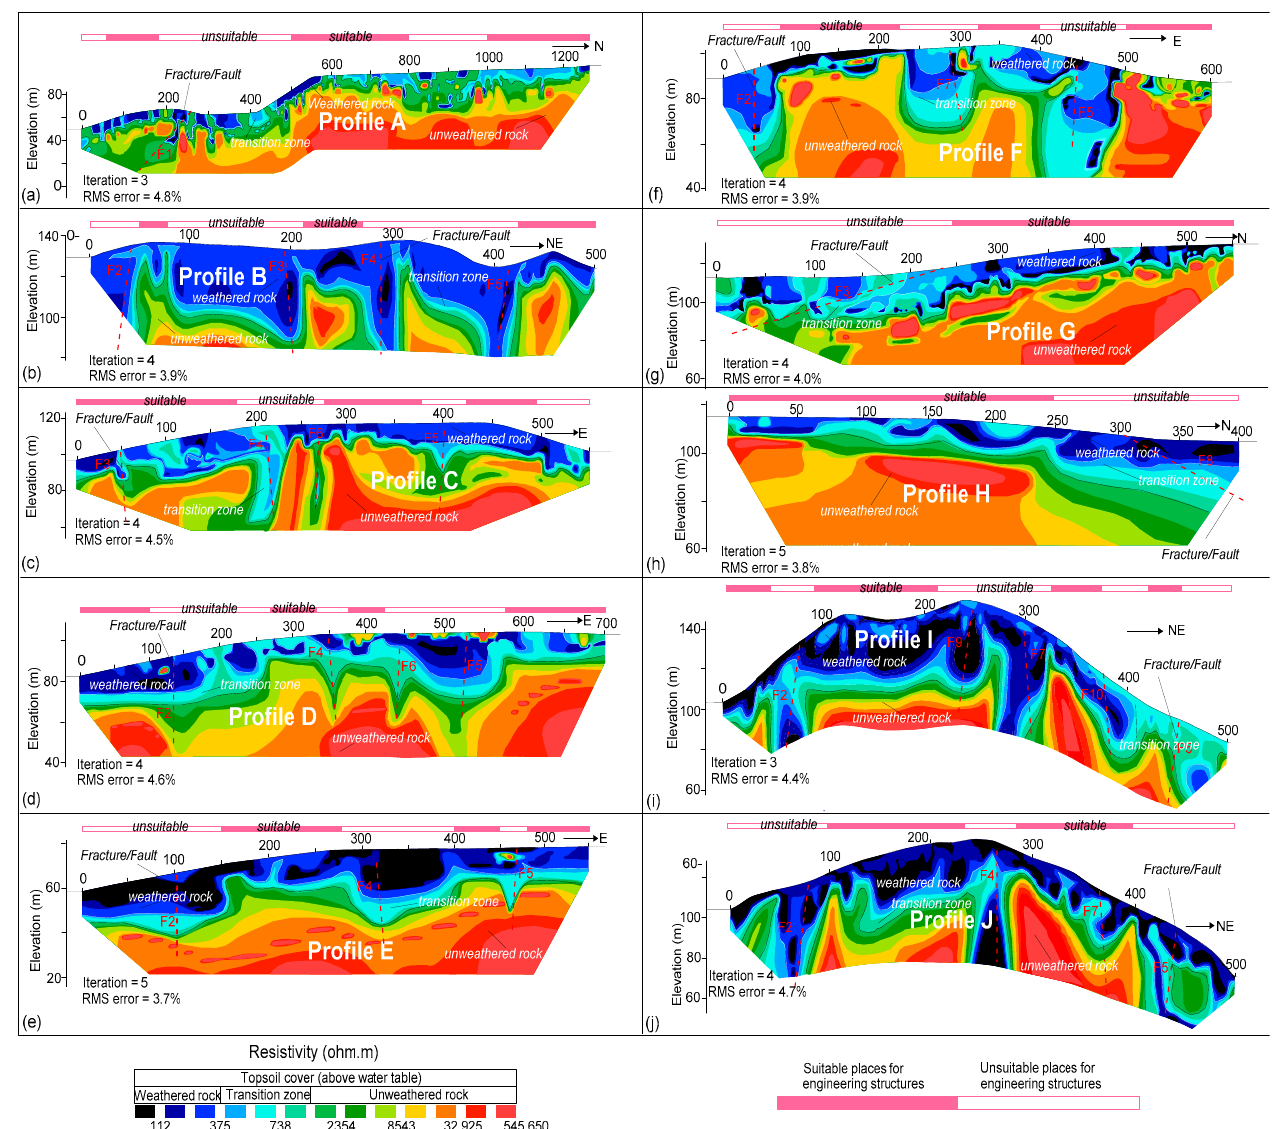
Figure 3. ( a – j ) 2D resistivity models of ERT (resistivity increasing from black to red on a color scale) along all geophysical profiles generated by the inversion program of RES2DINV. The zones marked by pink color on the top of each ERT model suggest suitable places for engineering structures, whereas the zones of white color indicate unsuitable locations for engineering structures.